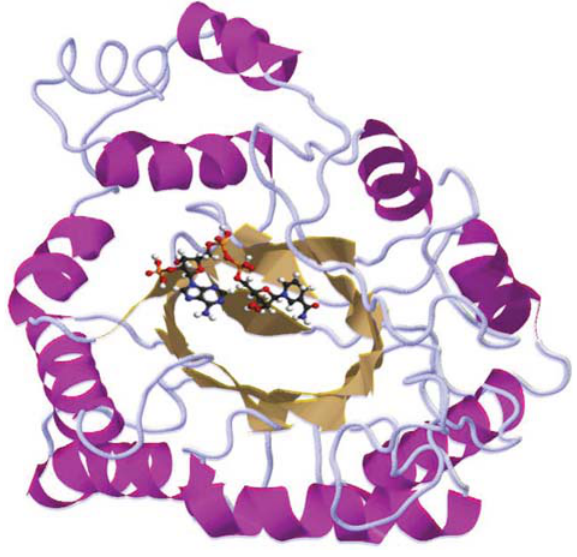
Figure 1 Crystal structure of the AKR1B1 Ø NADPH binary complex.